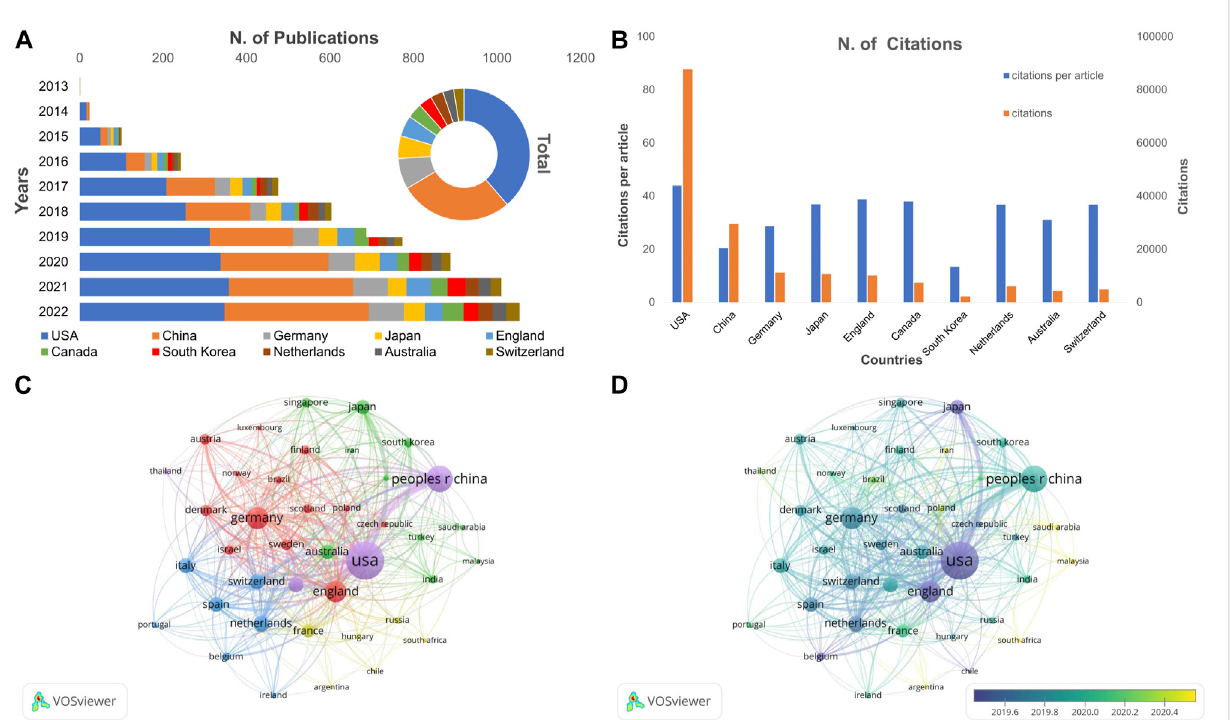
FIGURE 6 The analysis ofleadingcountries/regions andco-authorships on CRISPRincancer. (A) Annualand totalpublication volume forthetop 10countries. (B) Total citations, and average citations per article for the top 10 countries. (C) Network visualization map of the leading countries collaboration. (D) Overlay visualization map of the leading countries